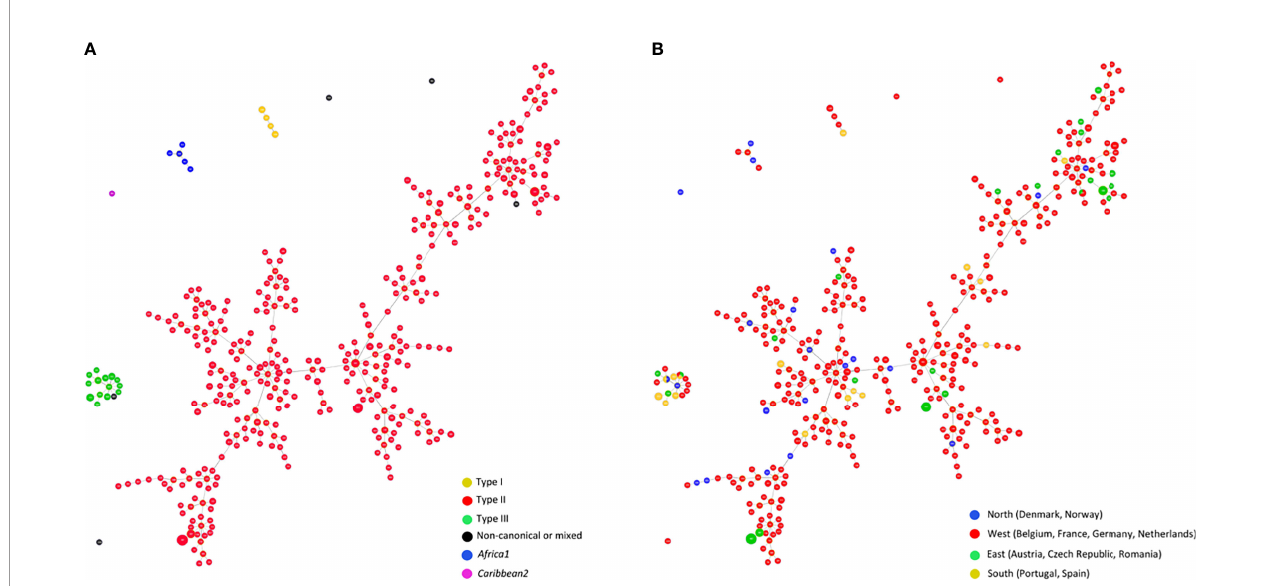
FIGURE 5 | Global optimal eBURST analysis using the Full-MST (goeBURST distance) option of European Toxoplasma gondii samples typed by 15 MS regions. In total, n = 487 isolates microsatellite typed at all 15 microsatellite markers were included, representing n=384 separate microsatellite types. Applying a Locus Variant Level 4, types clearly separated into four major groups; each circle represents an individual type; size of circles correlates with total number of samples with identical pro fi le. (A) Distribution by genotypes of the population, distinguishing between Type I, II, III, non-canonical or mixed patterns, Africa1 , and Caribbean2 types. (B) Geographical distribution of the population distinguishing between samples from North, West, East or South Europe. Type I, type III and non-canonical T. gondii types, including also a group representing Africa1 type, are clearly separated from Type II while no clear regional patterns can be observed in Type II T. gondii